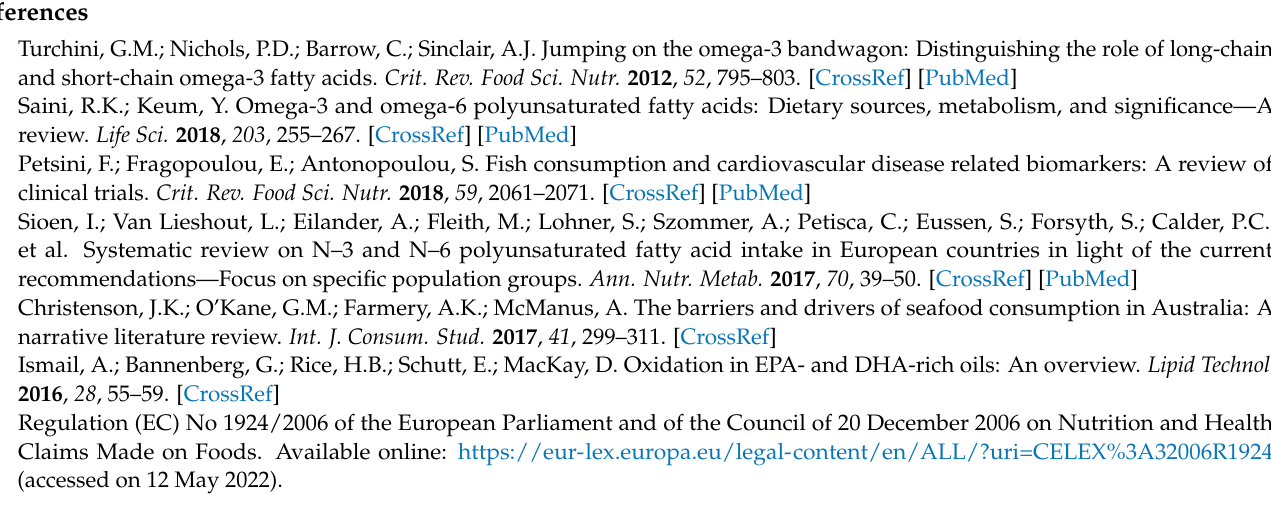
Figure A1. PCAs of selected volatile oxidation indicators in fresh and stored cookie ( A , B ) and chocolate ( C , D ) food model (n = 3). In scores plots: blue = fresh, red = stored; in loadings plots: 3 = propanal, a = 2-ethylfuran, 8 = acetic acid, b = 1-penten-3-ol, 11 = pentanal, 15 = propanoic acid, 22 = hexanal, 24 = butanoic acid, c = 2-hexenal ( E ), 33 = heptanal, 42 = hexanoic acid, d = 3,5-octadien-2- one ( E,Z ), 48 = nonanal, e = 5-ethyl-2(5H)-furanone, f = 2-nonenal ( E ).